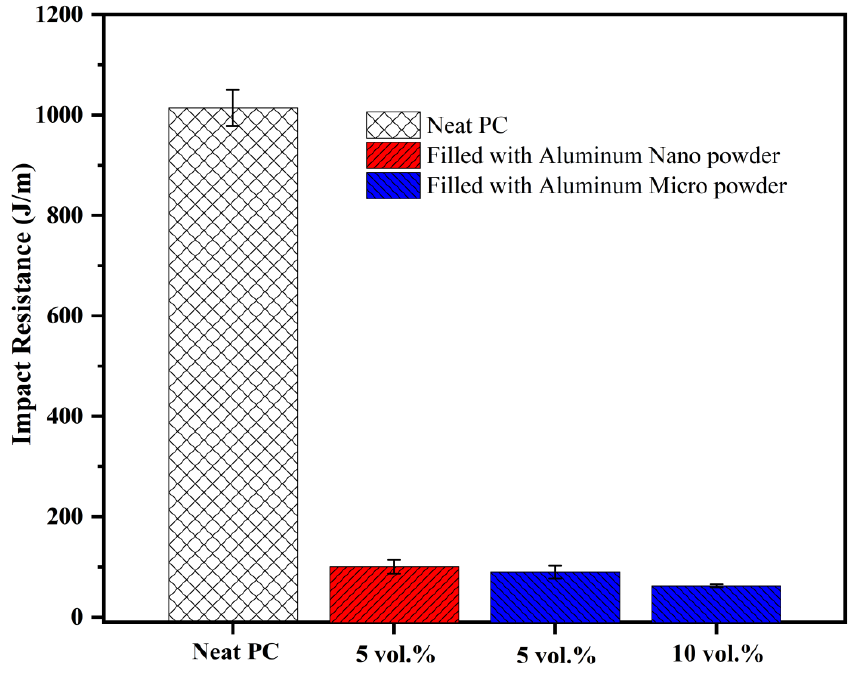
Figure 12. Comparison of Impact resistance of PC and micro and nano Al-PC composites, with standard deviation